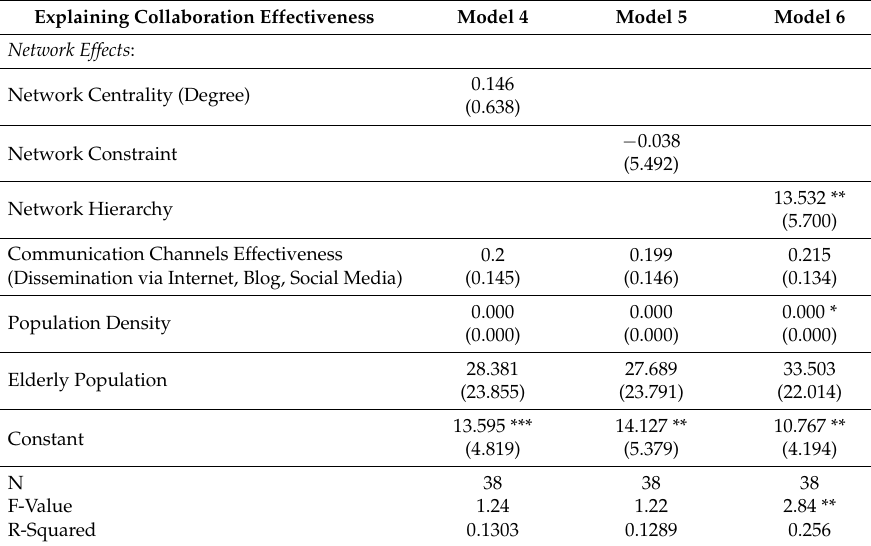
Table 5. Explaining collaboration effectiveness (local agencies